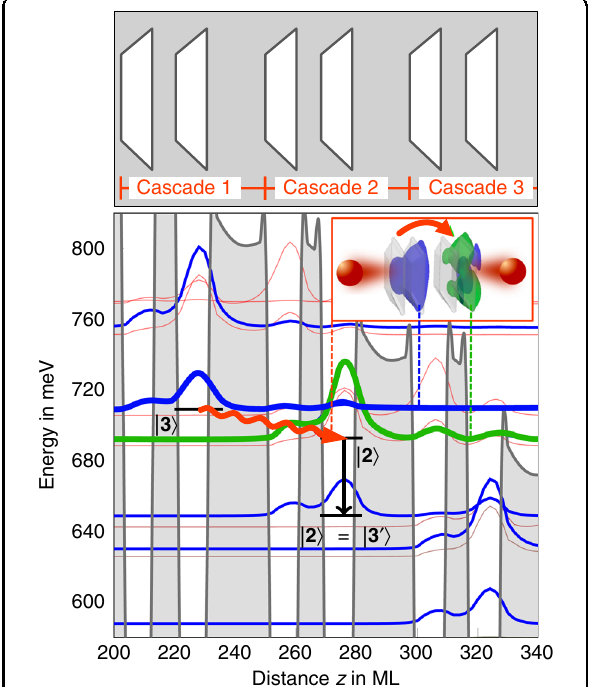
Fig. 11 Segment of the conduction band staircase potential for the QD chain of 20 InGaAs/GaAs QDs (shaded gray), with an alternating barrier sequence of 8 and 20 monolayers. The single-particle states of the QD chain are depicted in blue, with the upper laser level 3 j i (s- type) and the lower laser level 2 j i (px, y-type). The wavy red arrow indicates the laser transition, and the orbitals involved are displayed in the inset. Shown are two cascades of the QD chain, which consists of seven in total. The applied external bias voltage is set to 46